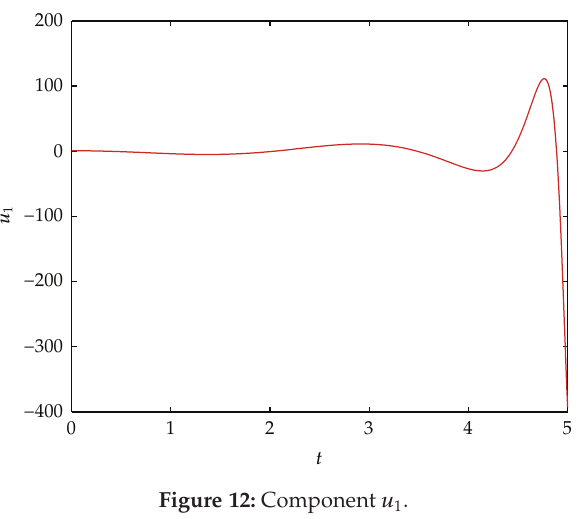
Figure 12: Component u 1